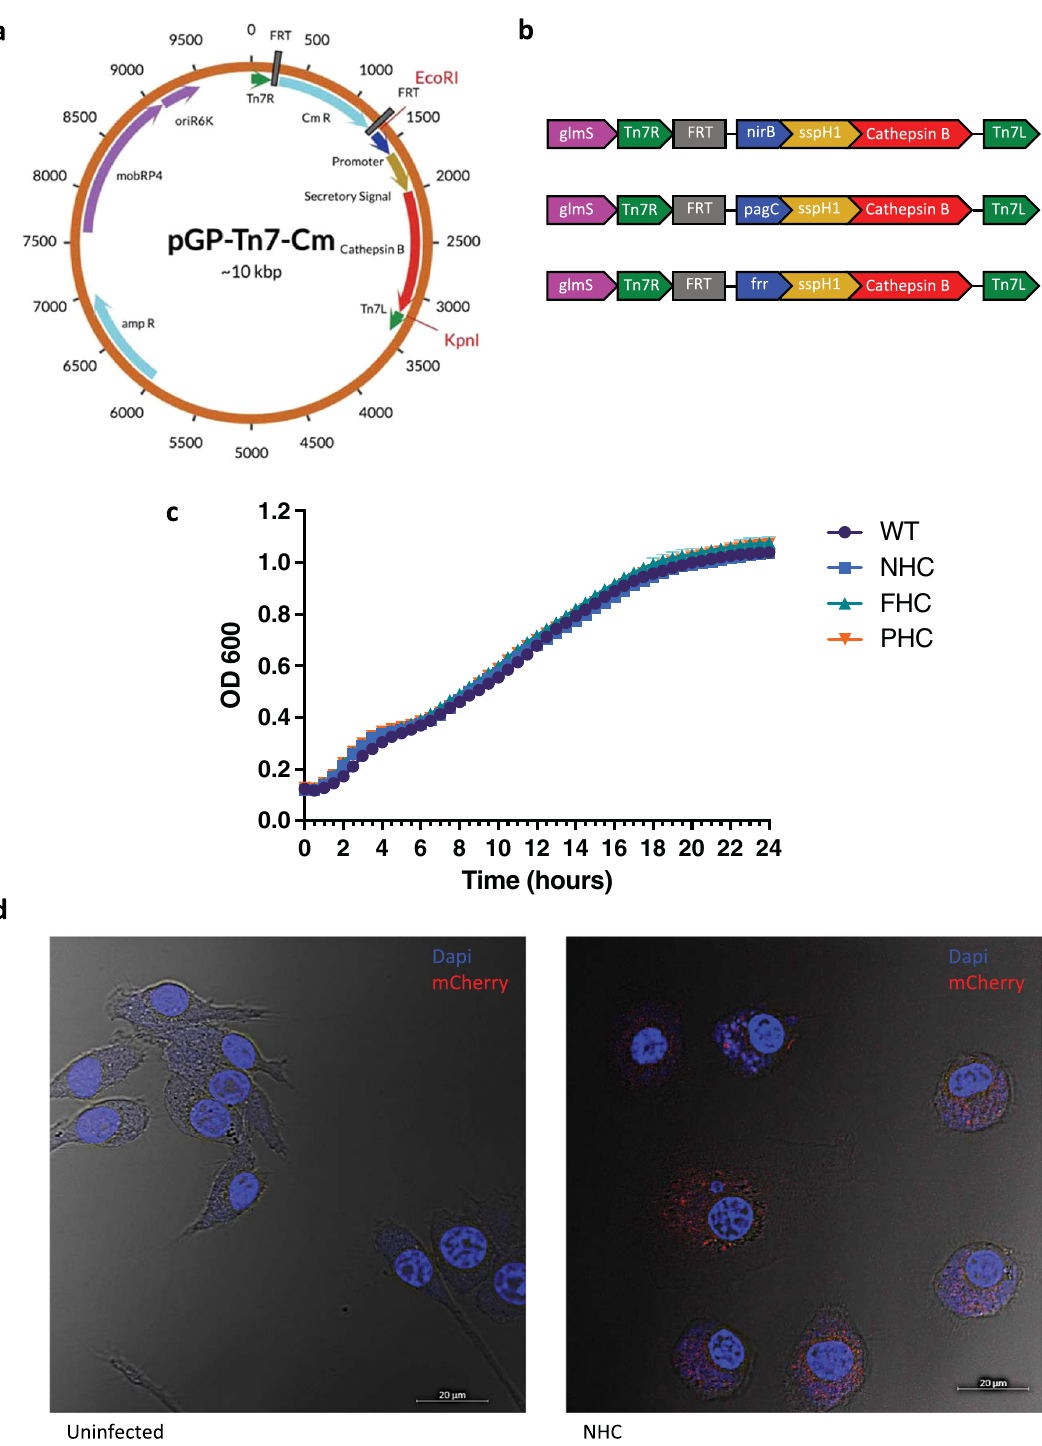
Fig. 1 Chromosomal integration. Map of the pGP-Tn7-Cm plasmid designed to include a promoter, secretory signal, and CatB antigen. Insertion occurred between the EcoRI and KpnI restriction sites ( a ). Linear integrated sequences for each YS1646 construct following FLP-FRT recombination to remove the chloramphenicol resistance gene ( b ). Growth curves of WT and recombinant YS1646 strains measured by absorbance at OD 600 over 24 h ( n = 4 readings per 30 min interval) ( c ). Confocal microscopy images of uninfected and infected RAW264.7 cells at 63X magni fi cation. DAPI nuclear stain is represented in blue and mCherry expression is shown in red ( d ). The scale is set to 20 μ